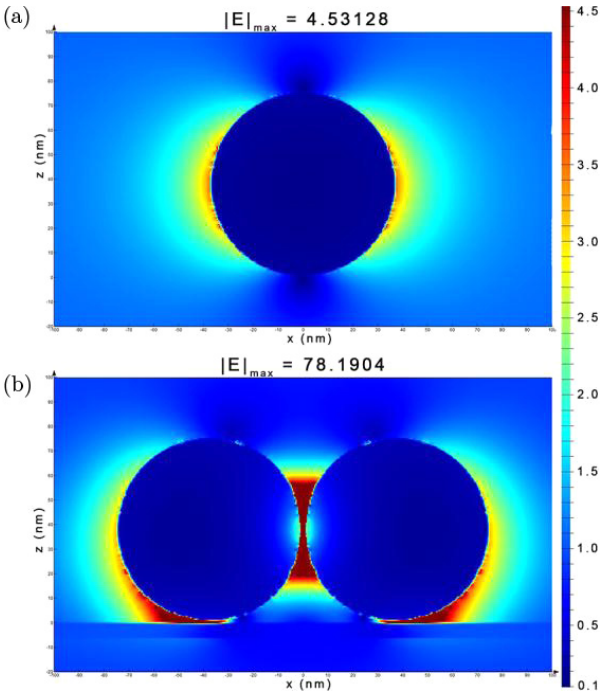
Fig. 5. 3D-FDTD simulation of the electromagnetic ¯eld distribution around (a) a discrete Au NP and (b) two adjacent Au NPs on HfTe 2 nanosheet, respectively.